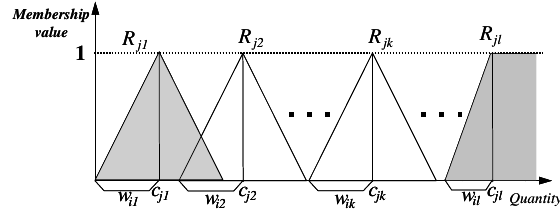
Fig. 3. The set of membership functions for an item I j